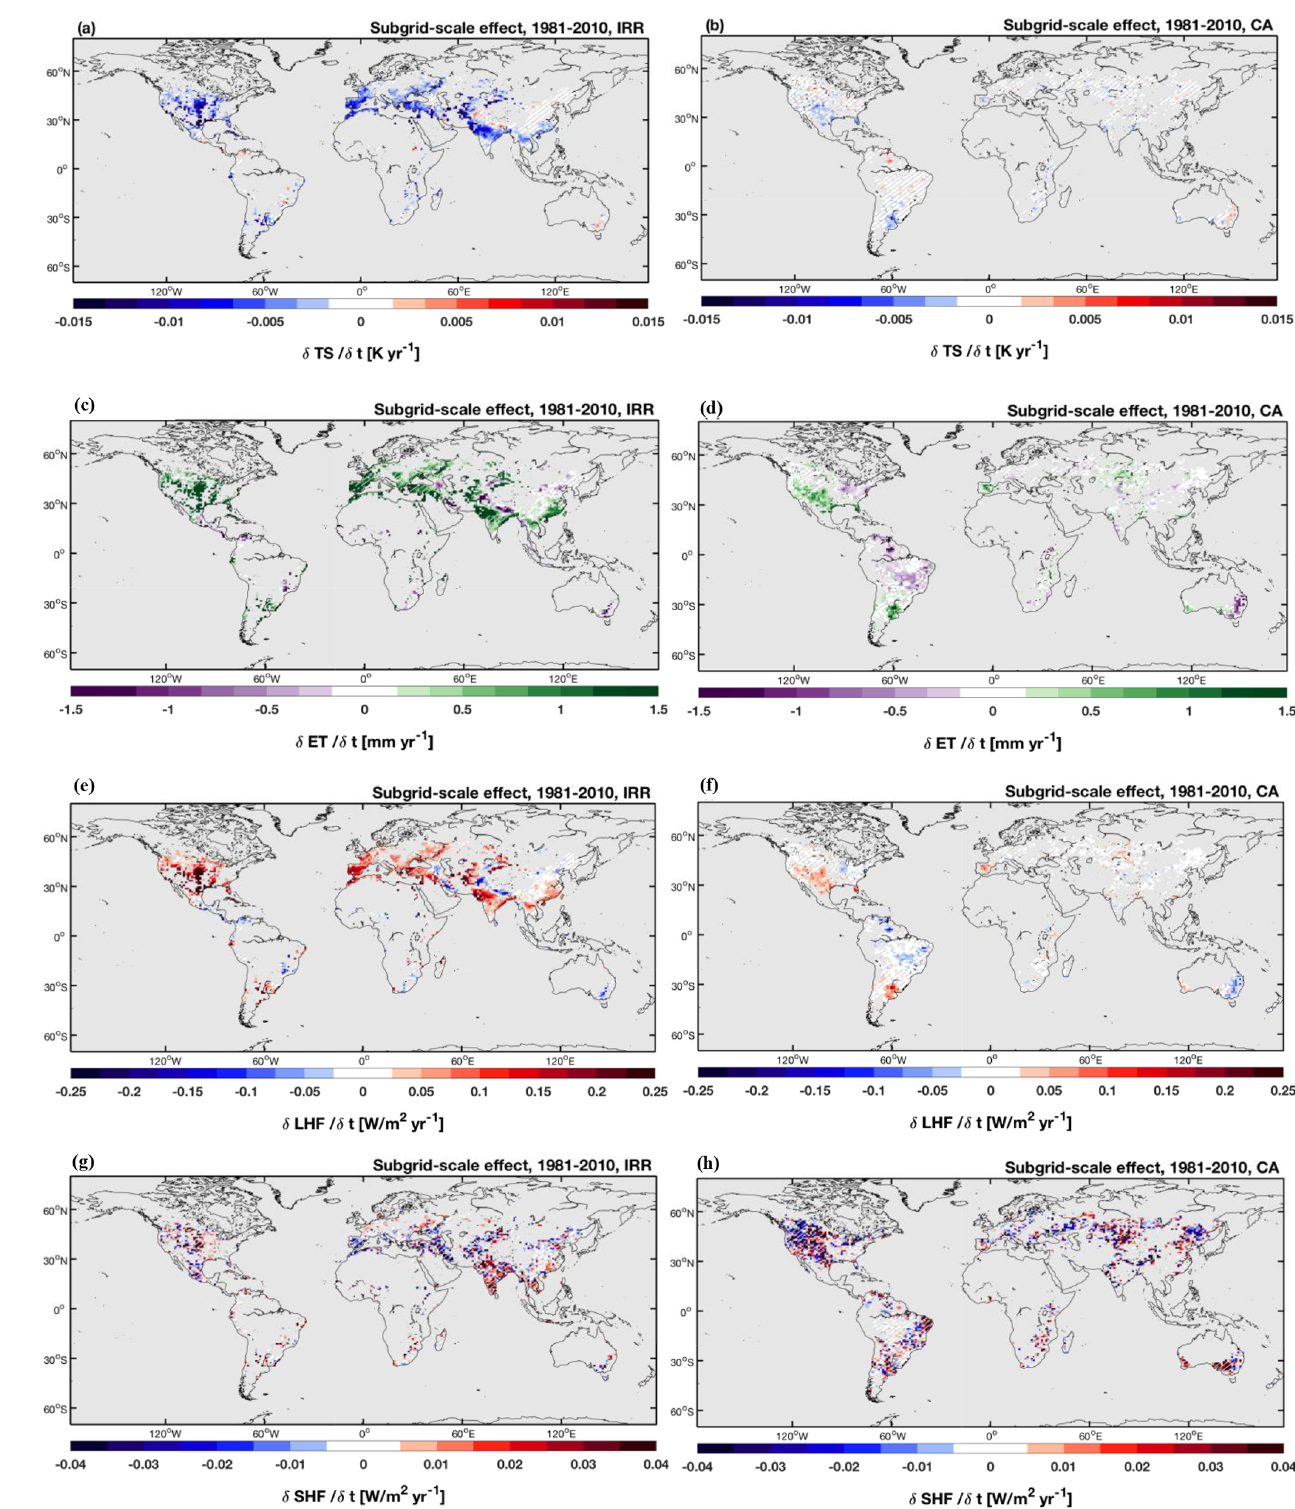
Figure 6. Subgrid-scale differences between the irrigated and rainfed crop tile in the IRR ensemble (irrigated minus rainfed) (a, c, e, g) and between CA and conventionally managed (CM) crops (CA minus CM) (b, d, f, h) . For T s (a, b) , ET (c, d) , LHF (e, f) and SHF (g, h) , displayed over irrigated/CA pixels for comparative purposes. Differences are based on the ensemble mean warming trends of each experiment for 1981–2010. Hatching denotes less than 10% change induced by the model on mean warming trends of lumped ensemble members. Earth Syst. Dynam., 13, 419–438,